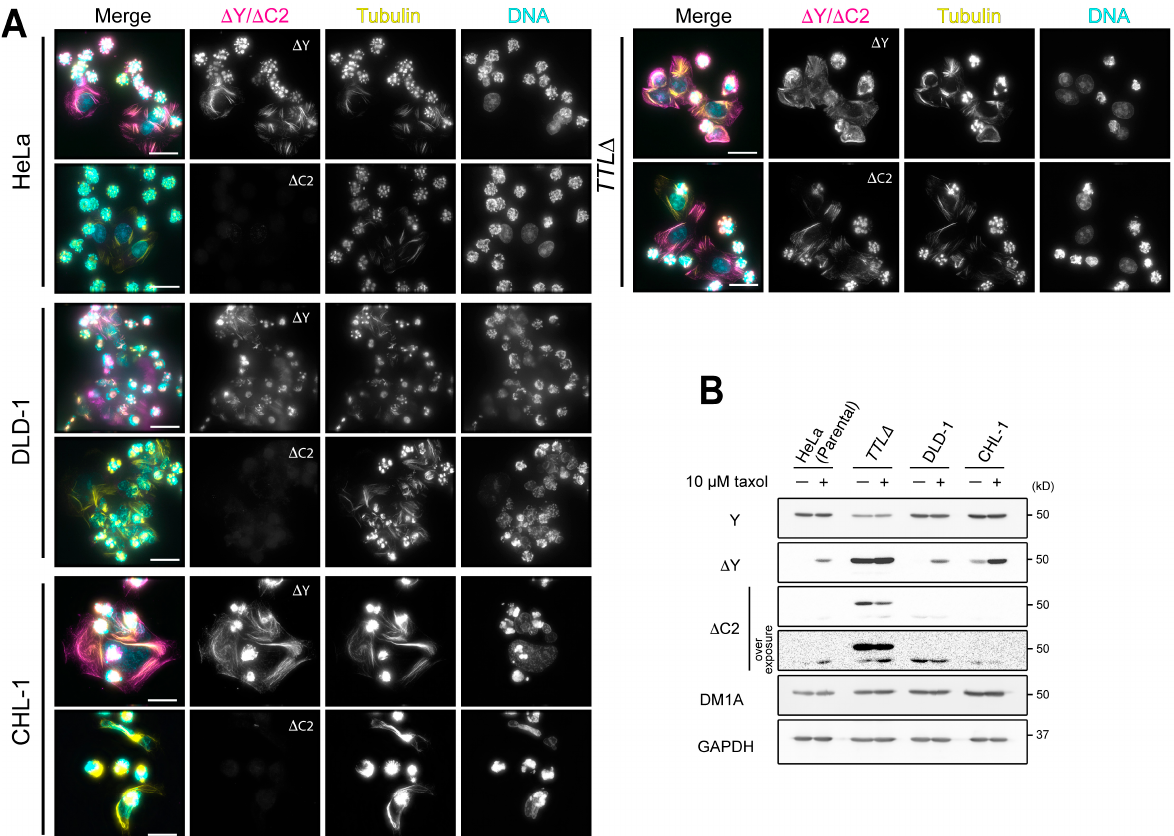
Figure 2. Taxol treatment increases the levels of Δ Y- α -tubulin but not Δ C2- α -tubulin in cells. ( A ) Detection of ∆ Y- and ∆ C2- α -tubulin in taxol-treated HeLa, DLD-1, CHL-1, and TTL ∆ cells by immunofluorescence ( A ) and immunoblotting in whole cell lysates ( B ). In merged images in ( A ), ∆ Y- or ∆ C2- α -tubulin is shown in magenta, total α -tubulin (DM1A staining) in yellow, and DNA (DAPI staining) in cyan. Scale bars in ( A ), 25 µm.